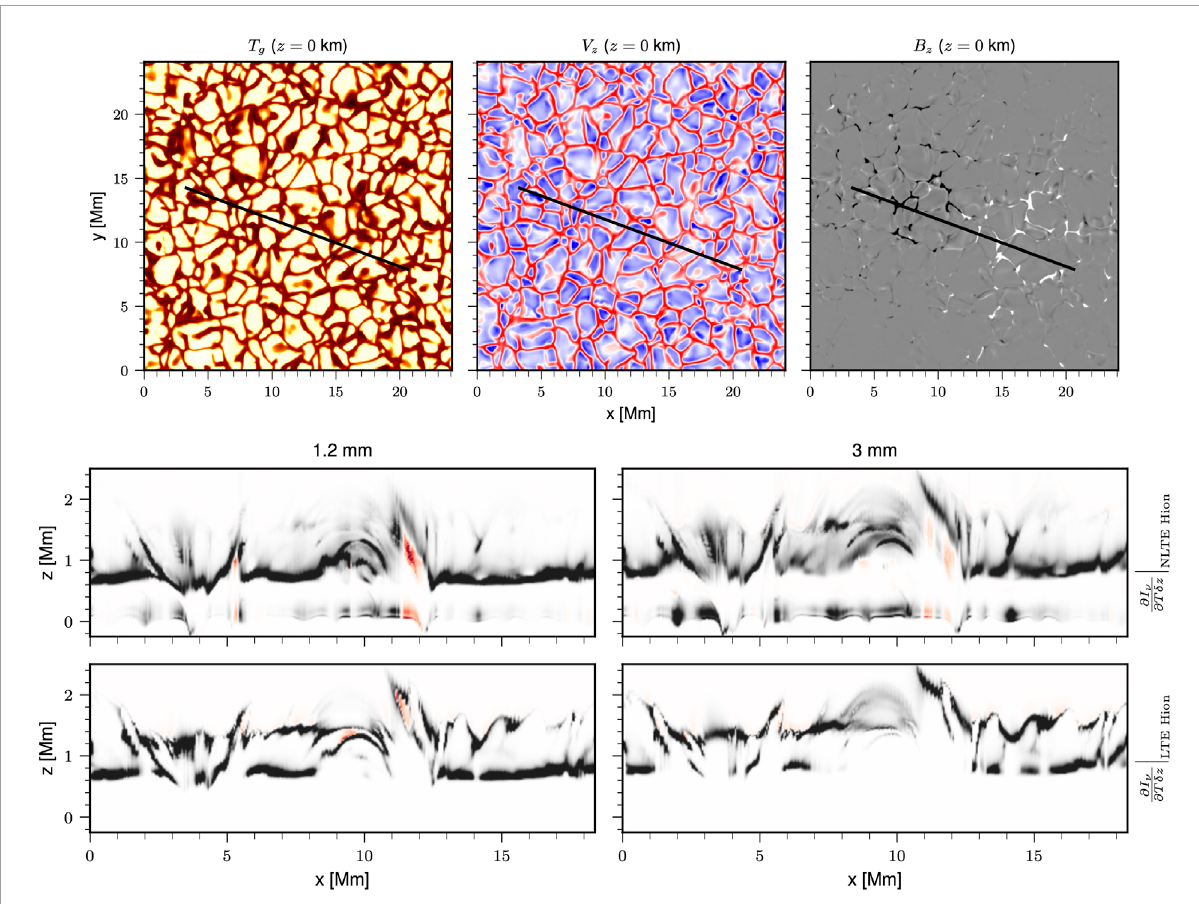
FIGURE 4 Temperature response function computed with the STiC code at 1.2 mm and 3 mm from a vertical slice of a 3D MHD model (Carlsson et al., 2016). In the middle row, the response function has been calculated with an NLTE equation-of-state where the hydrogen population densities are calculated in statistical equilibrium and charge conservation has been imposed in order to calculate the electron density. In the bottom row, an LTE case is shown. For context, we have indicated the location of the slice in the upper row over-imposed on the photospheric temperature, the line-of-sight velocity, and the vertical component of the magnetic field